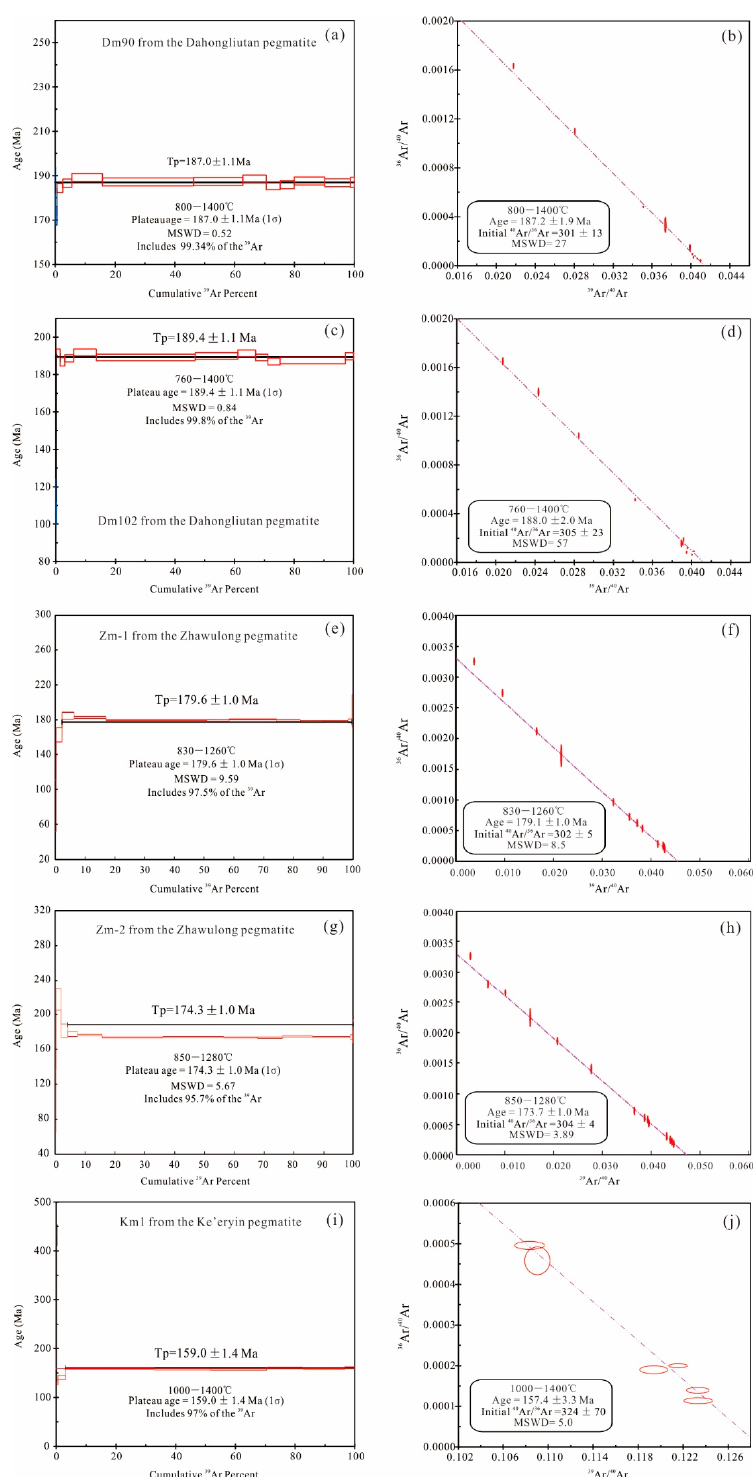
Figure 8. 40 Ar / 39 Ar plateau age spectra (left) and inverse isochron age spectra (right) for muscovite samples from the pegmatite dikes of the Dahongliutan, Zhawulong, and Ke’eryin deposits in the Songpan–Ganz ê orogenic belt. ( a – d ) 40 Ar / 39 Ar plateau age spectra (left) and inverse isochron age spectra (right) for muscovite samples from the Dahongliutan pegmatites; ( e – h ) 40 Ar / 39 Ar plateau age spectra (left) and inverse isochron age spectra (right) for muscovite samples from the Zhawulong pegmatites; ( i , j ) 40 Ar / 39 Ar plateau age spectra (left) and inverse isochron age spectra (right) for muscovite samples from the Ke’eryin